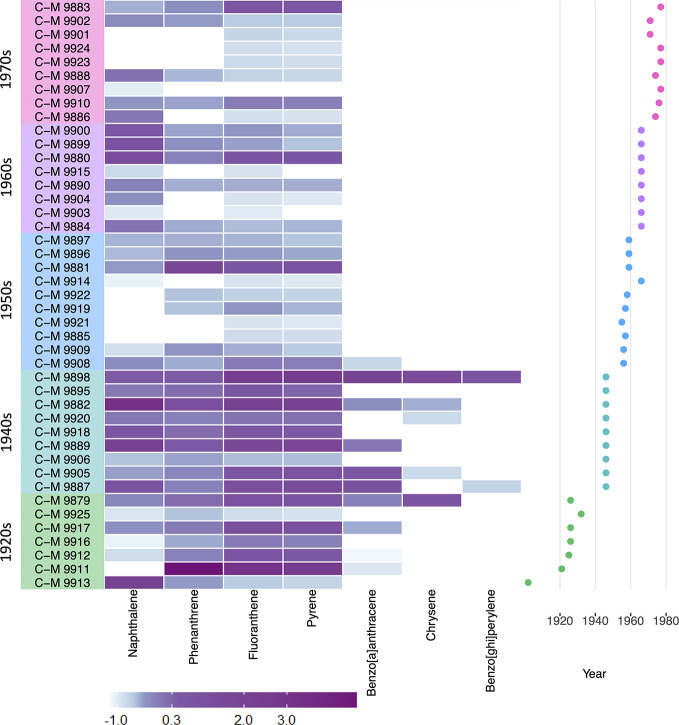
Heat map of detected PAHs across all samples divided by time period in which they were collected (1920s–1970s). The concentrations are normalized and assigned a score (column Z-score) and corresponding color, with blue being the lowest values and purple the highest amounts of compound detected in the sample. The Z-score is calculated based on the number of standard deviations that the value of the sample is above or below the mean.